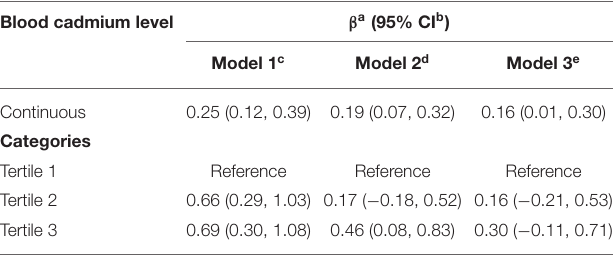
TABLE 2 | Multivariate logistic regression models of AAC score with blood cadmium levels.